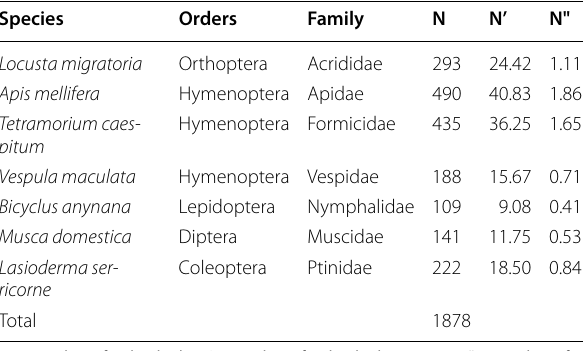
Table 3 Average density and recovery rate of identified insects from sampling area